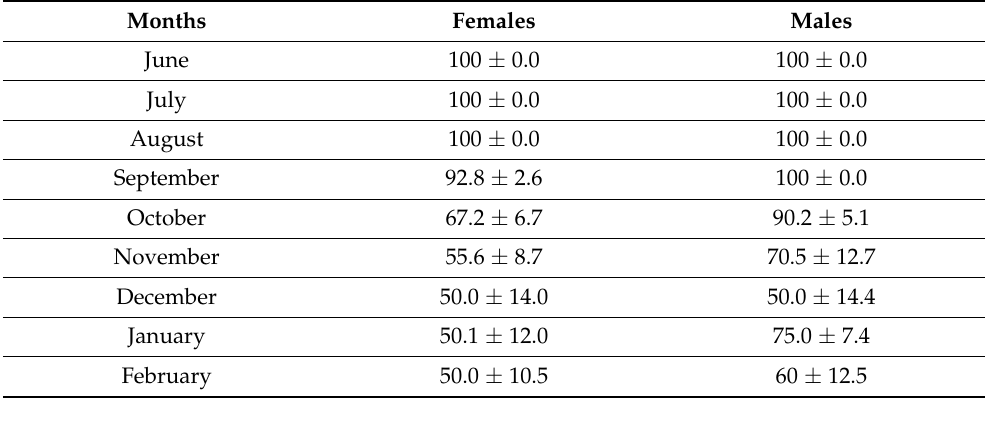
Table 2. Percentage (mean ± SE) of Cirrospilus pictus wasps belonging to classes I and IV (yellow females and males) detected in the months of active infestation of Phyllocnistis citrella in 4 years (2000–2003).